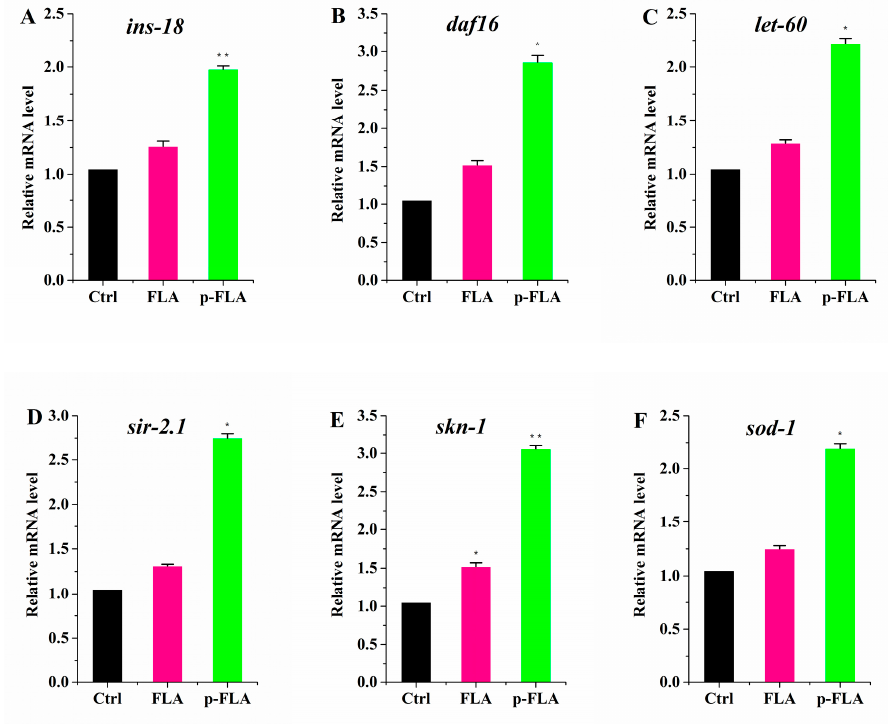
Figure 6. Anti-aging and antioxidant e ff ect of FLA and p-FLA in C. elegans . ( A )–( D ): 2 mg / mL p-FLA extracts significantly increased the expression of ins-18 , daf-16 , let-60 and sir-2.1 , which are key anti-aging genes; ( E ): 2 mg / mL p-FLA extracts up-regulate skn-1 expression; the e ff ect was three times greater than FLA extracts; ( F ): 2 mg / mL p-FLA extracts increased the expression of antioxidant enzyme sod-1 significantly. Error bars represent means ± SEMs (* p < 0.05, ** p < 0.01).